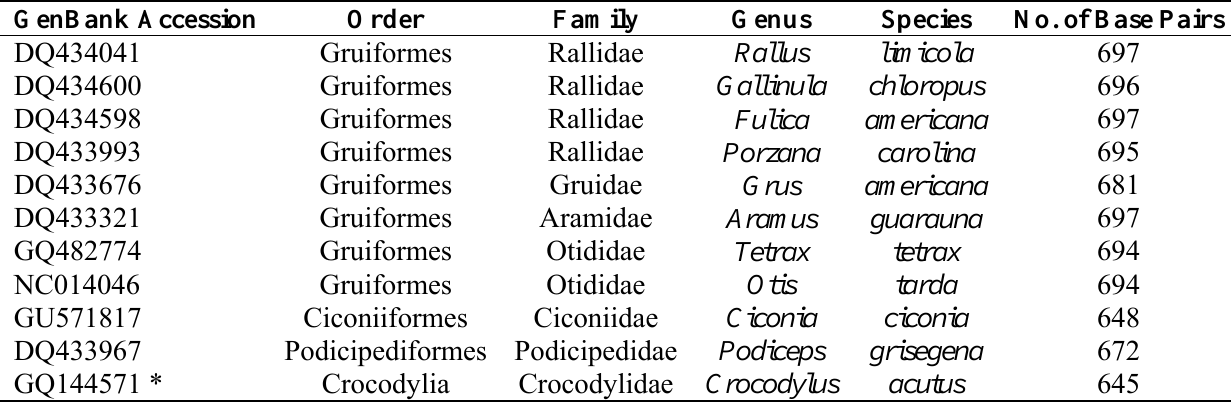
Table 3. GenBank sequences used for comparative